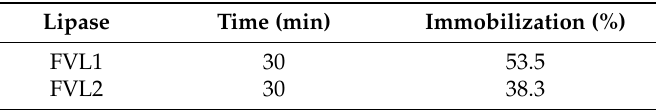
Table 3. F. verticillioides lipases immobilization at uni-punctual support.